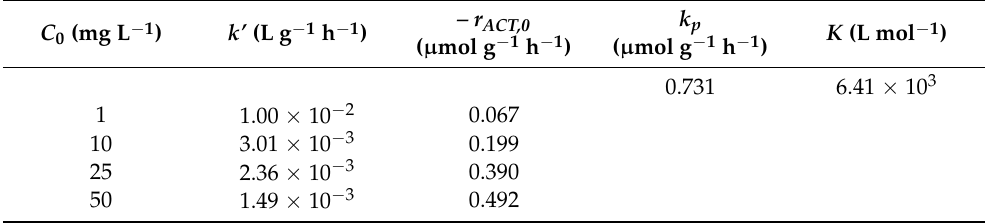
Table 2. Summary of the kinetic parameters obtained for ACT degradation on 0.25%Pt-TiO 2 /SiO 2 in a continuous fixed-bed microreactor ( v 0 = 3 mL h − 1 ; space time = 1